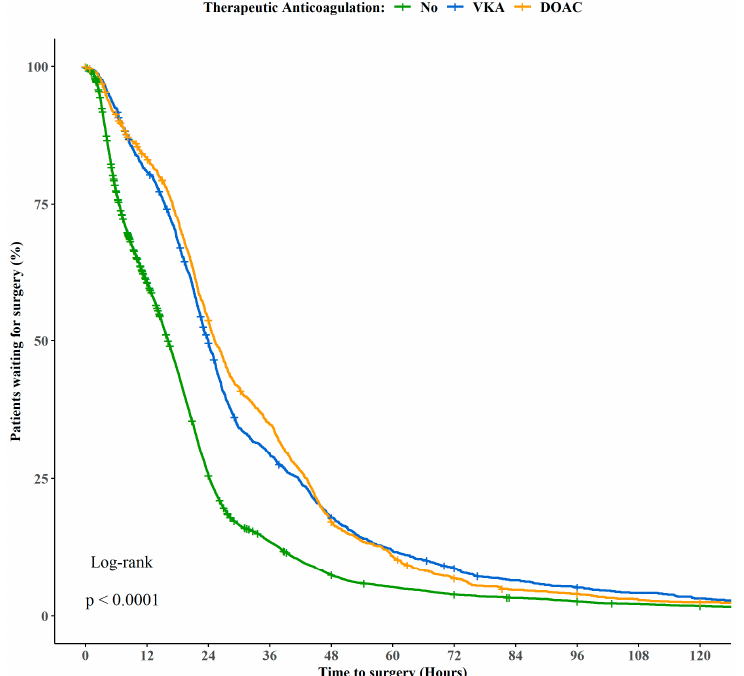
Figure 2. Kaplan–Meier curves of time-to-surgery for therapeutic anticoagulation treatment. VKA: Vitamin K Antagonist; DOAC: direct oral anticoagulants.